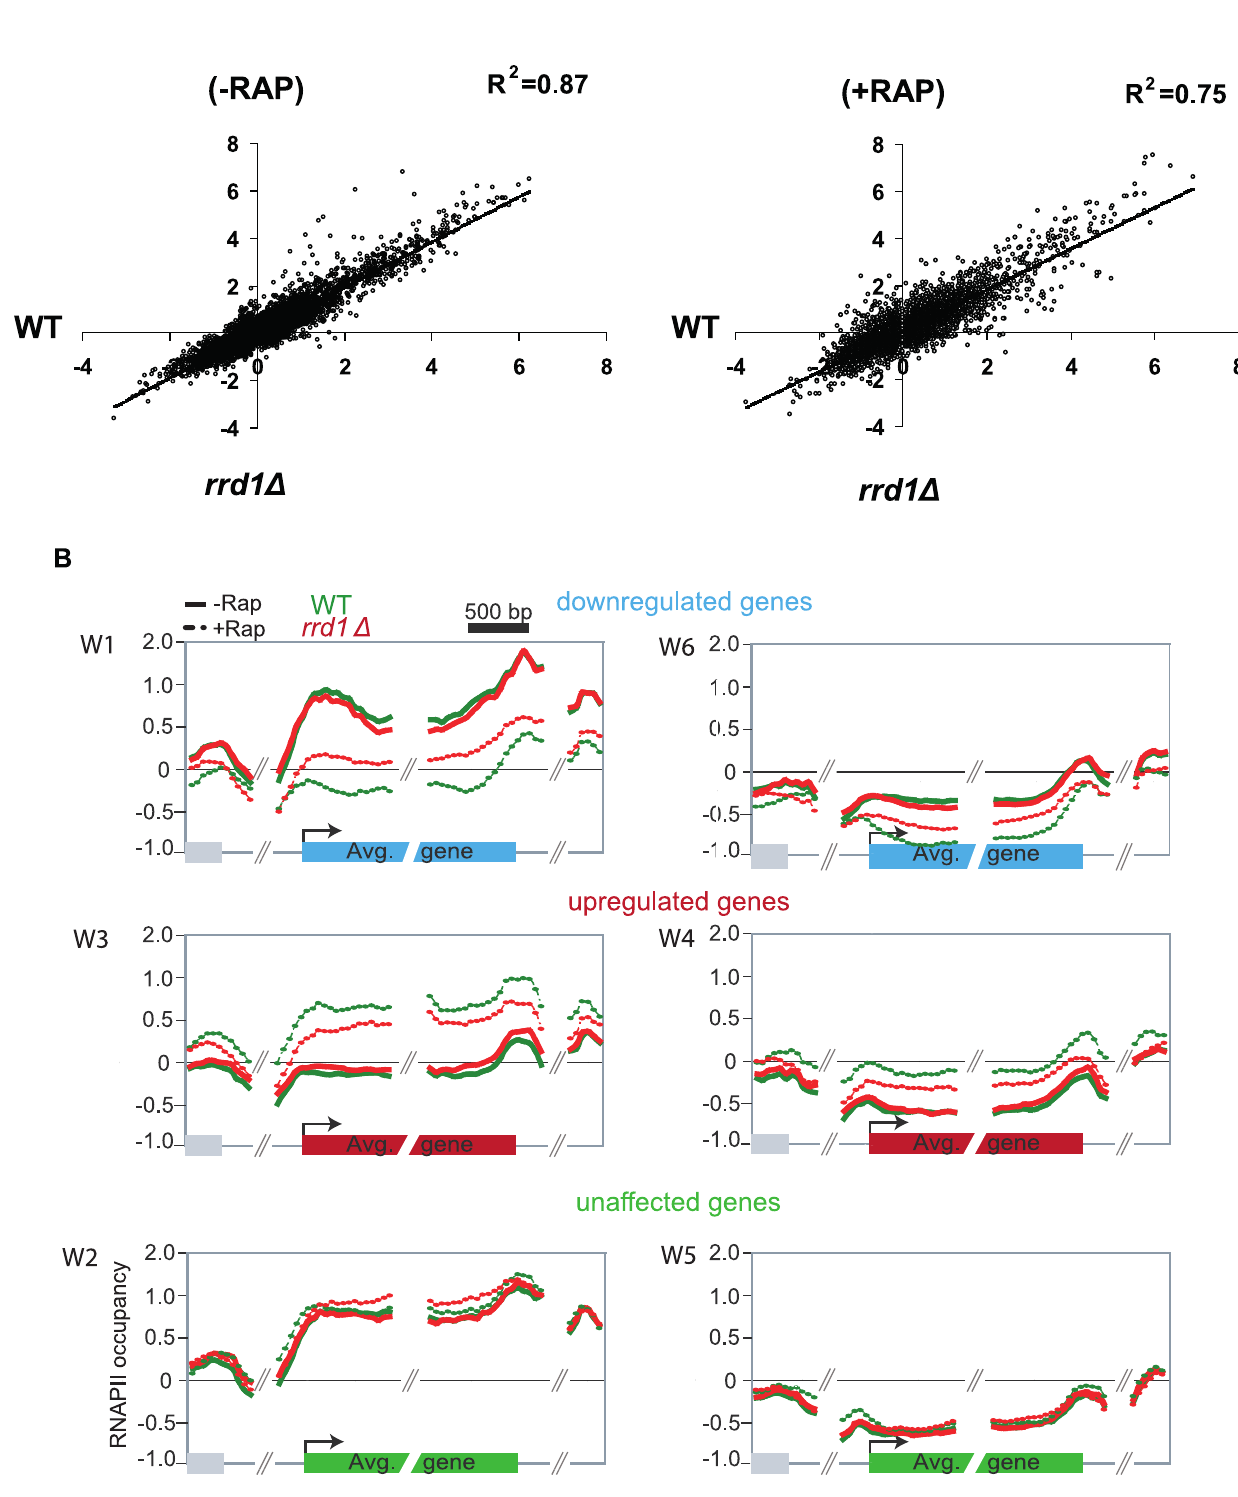
Figure 3. rrd1 D deletion affects RNAPII localization in response to rapamycin. ( A ) Linear correlation of RNAPII median enrichment of WT (x- axis) and rrd1 D mutant (y-axis) under normal growth conditions ( 2 RAP) (left panel) and rapamycin treated conditions ( + RAP) (right panel). The trend line and the R 2 value are displayed for each condition. ( B ) Mapping of RNAPII from WT cells (green line) and rrd1 D mutant cells (red line) under normal growth conditions (full line) and rapamycin treated conditions (dotted line) on cluster W1–W6 from figure 2A. Mappings are sorted for unaffected genes (green) upregulated genes (red) and downregulated genes (blue).